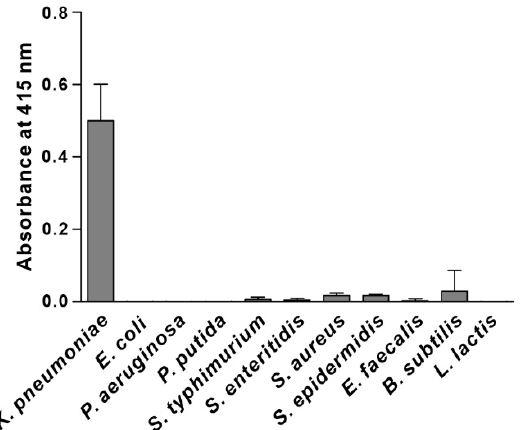
Figure 1. Specificity and selectivity of phage clone binding to K. pneumoniae . The binding of the selected phage clone to different bacterial cells was determined by phage-binding ELISA. Microtiter plates were coated with bacterial cells, incubated with the selected phage clone, and then incubated with HRP-conjugated anti-M13 antibody. The substrate ABTS was used to detect the positive binding of the phage clone to bacteria. The data are presented as the mean ± SD of three independent experiments performed in triplicate.